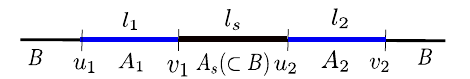
Fig. 1 Twodisjointintervals A 1 and A 2 ,separatedby A s ina CFT 1 + 1 . The remainder of the system denoted by B